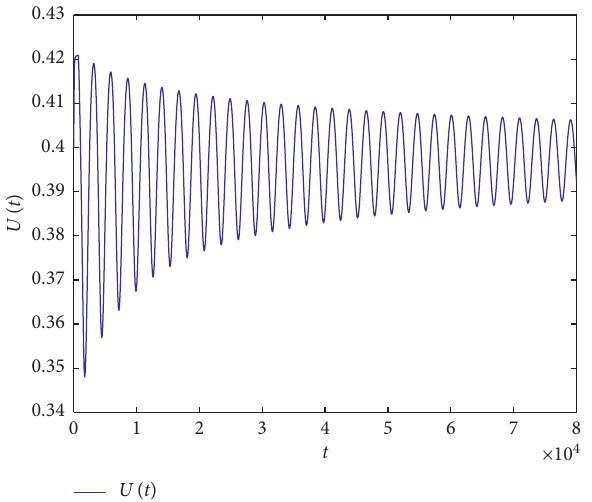
Figure 11: Time series solution of system (30) with ϕ � 0 . 90, � 728 . 403. τ � 740 > τ 0